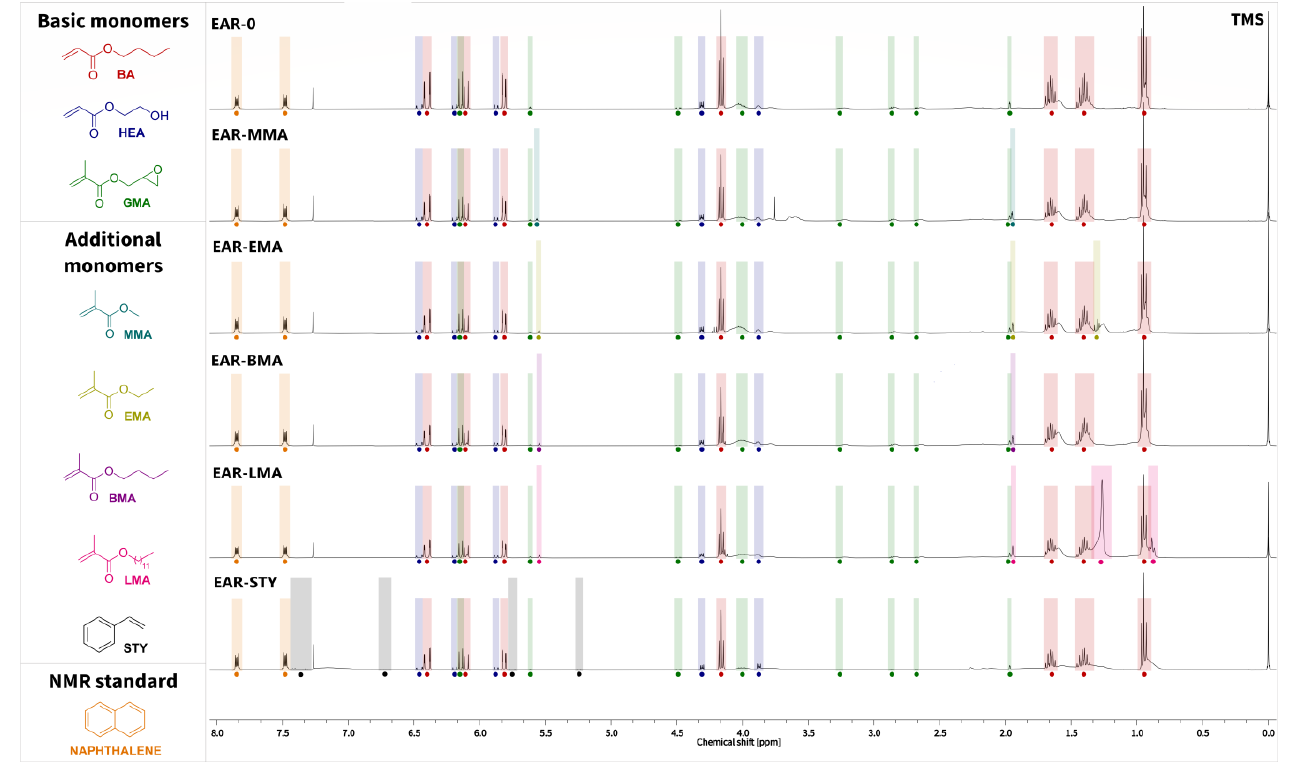
Figure 5. Stacked plot of the proton nuclear magnetic resonance ( 1 H NMR) spectra of epoxy acrylic resins. Peaks monitored for each monomer and the internal standard (naphthalene) are indicated.